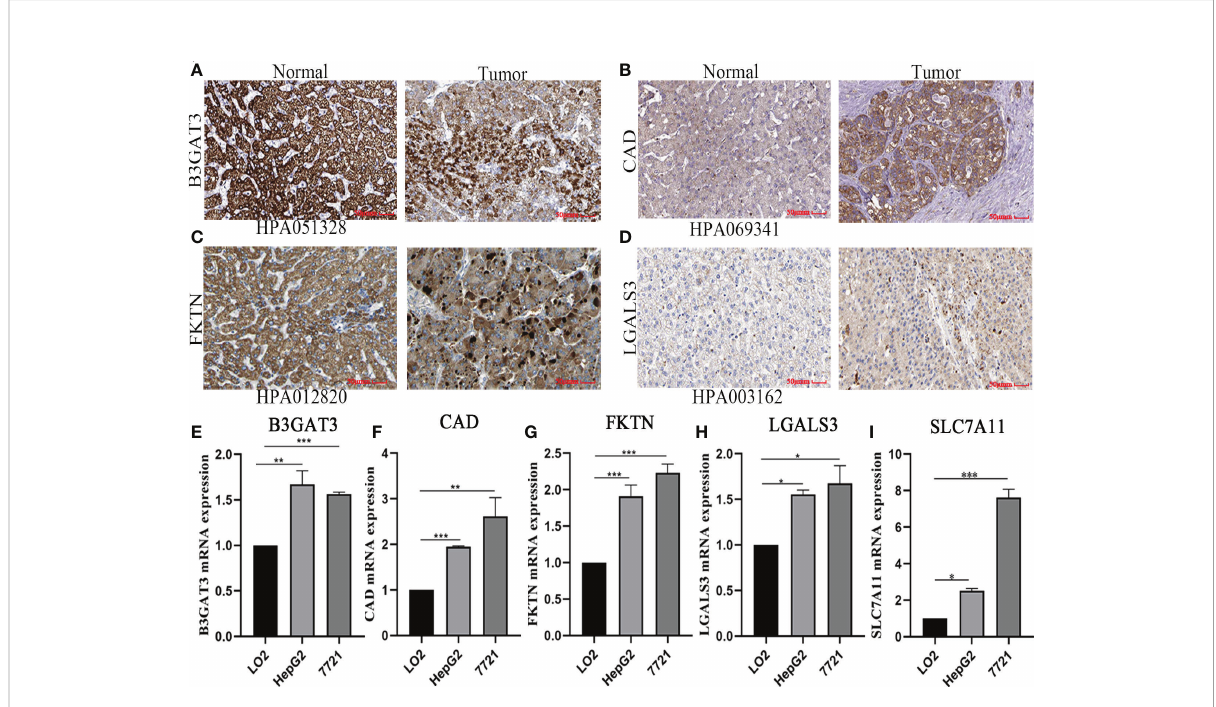
FIGURE 8 Veri fi ed protein and mRNA expression of the fi ve-gene signature. Protein expression in HCC and normal tissues validated by the immunohistochemistry analysis of the HPA database: (A) B3GAT3. (B) CAD. (C) FKTN. (D) LGALS3. The expression of fi ve-gene mRNA in hepatic and HCC cell lines experimented by quantitative real-time polymerase chain reaction analysis: (E) B3GAT3. (F) CAD. (G) FKTN. (H) LGALS3. (I)